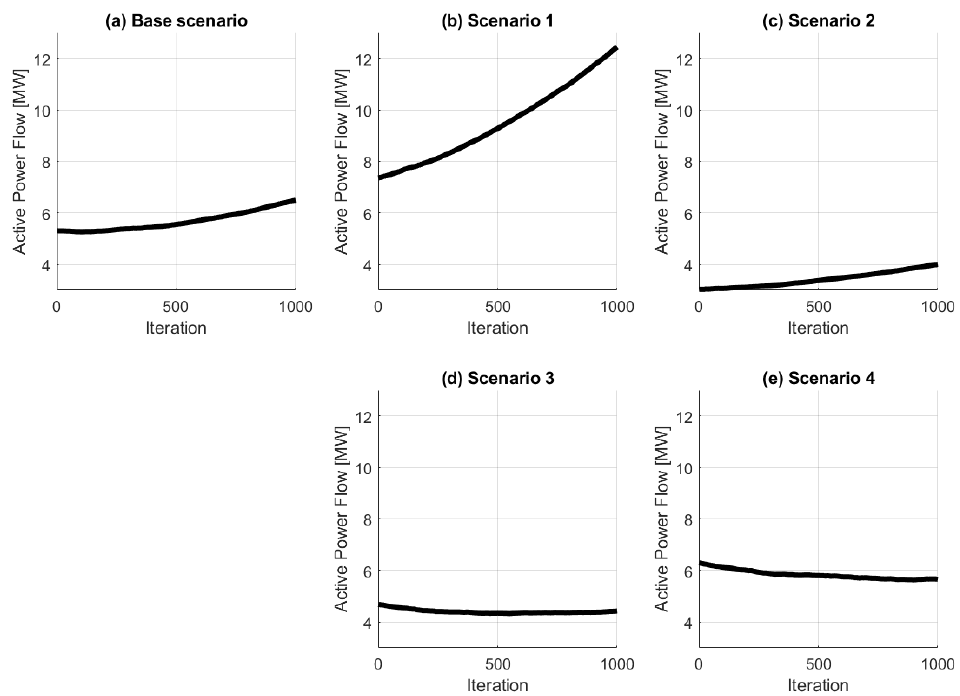
Figure 3. Power flowing from the substation at the time of maximal loading for the ( a ) base scenario; ( b ) scenario 1; ( c ) scenario 2; ( d ) scenario 3; and ( e ) scenario 4.